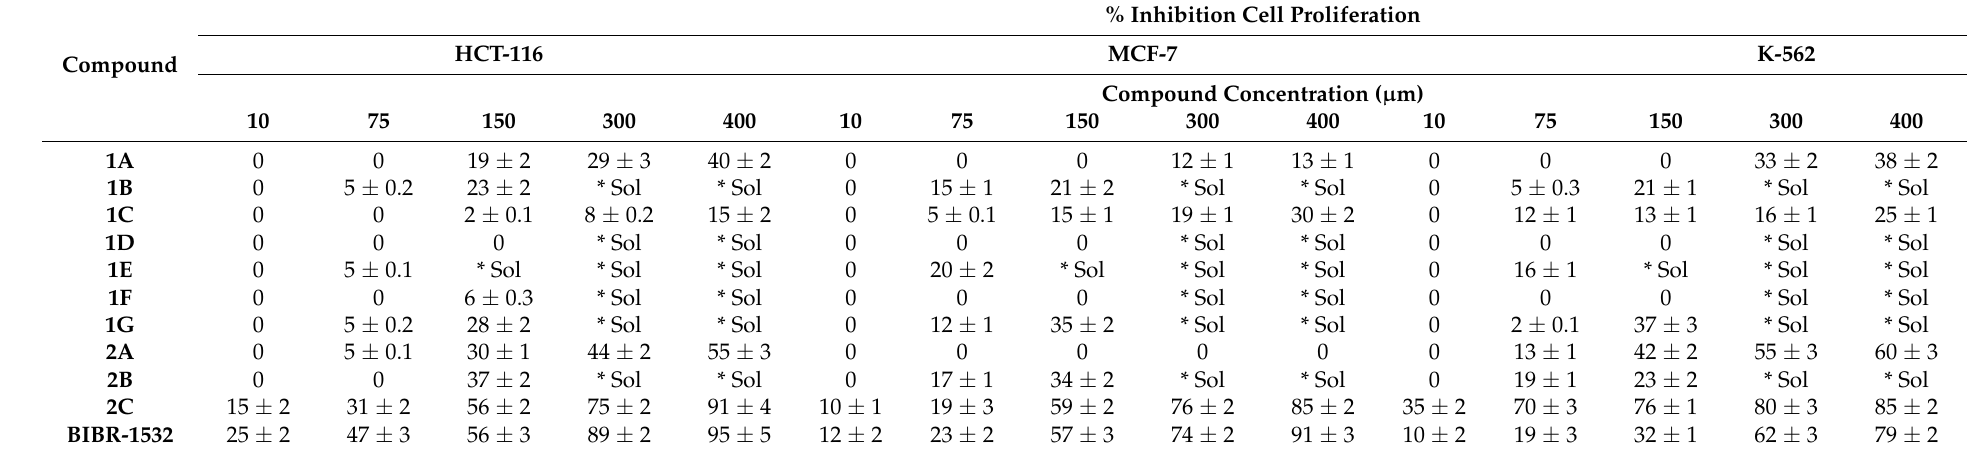
Table 2. Cytotoxicity of the synthesized compounds on human tumor cell lines HCT-116, MCF-7, and K-562. Cells were treated for 24 h in the absence or the presence of the compound tested at the indicated concentration, and cell viability was assessed by an MTT test as reported in Section 4. Values are expressed as the mean ± SD of three separate experiments conducted in triplicate. * Sol: solubility